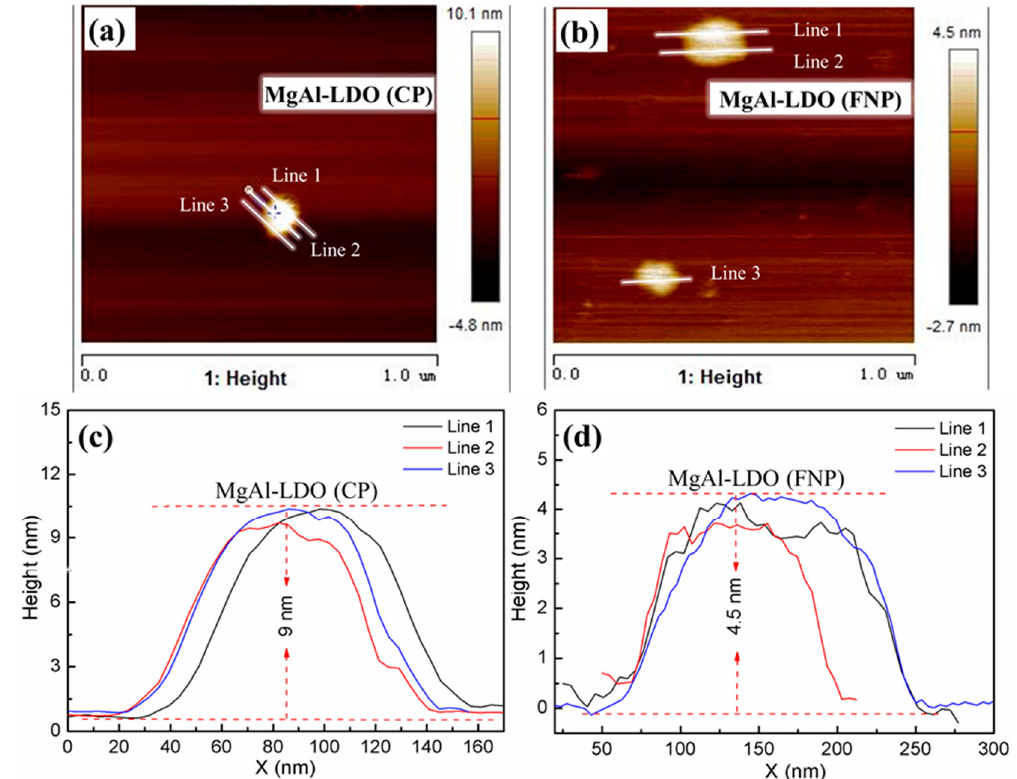
Figure 4. AFM images of ( a ) MgAl-LDO (CP), ( b ) MgAl-LDO (FNP) nanosheets, and the corresponding height curves of ( c ) MgAl-LDO (CP) and ( d ) MgAl-LDO (FNP).